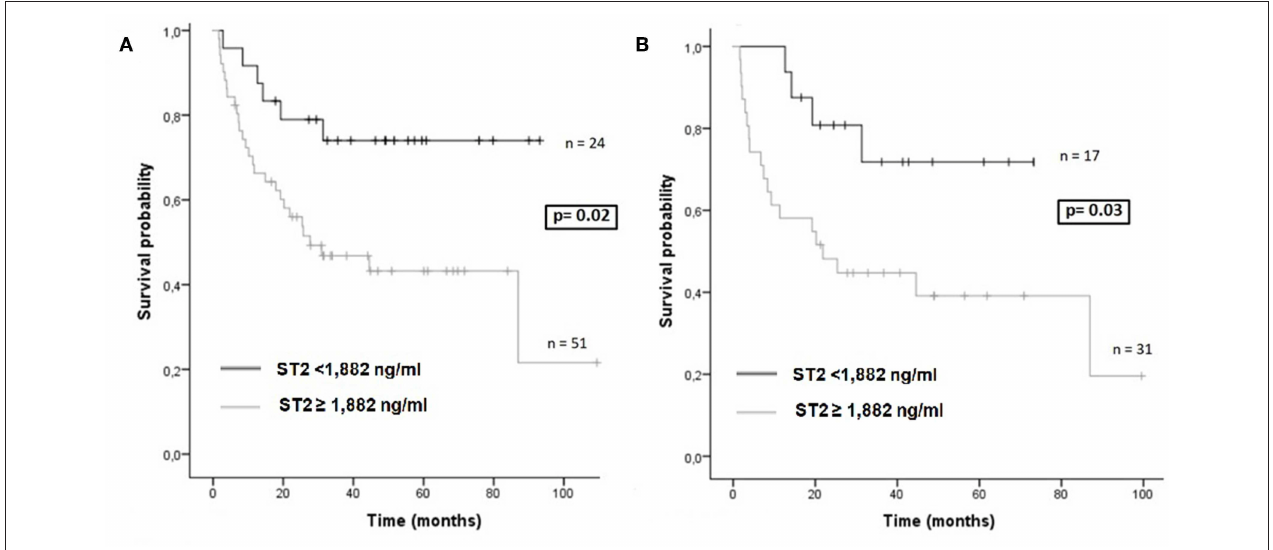
FIGURE 3 | (A) Overall survival according to ST2 levels at day + 30 (cut-off 1,882ng/ml) in the whole cohort ( n = 75). (B) Overall survival according to ST2 levels at day + 30 (cut-off 1,882ng/ml) in RIC patients ( n = 48). TABLE 7 | Association between REG3 α levels at day + 15 and + 30 and GVHD (acute and chronic), NRM, relapse, and status. Whole cohort ( n =